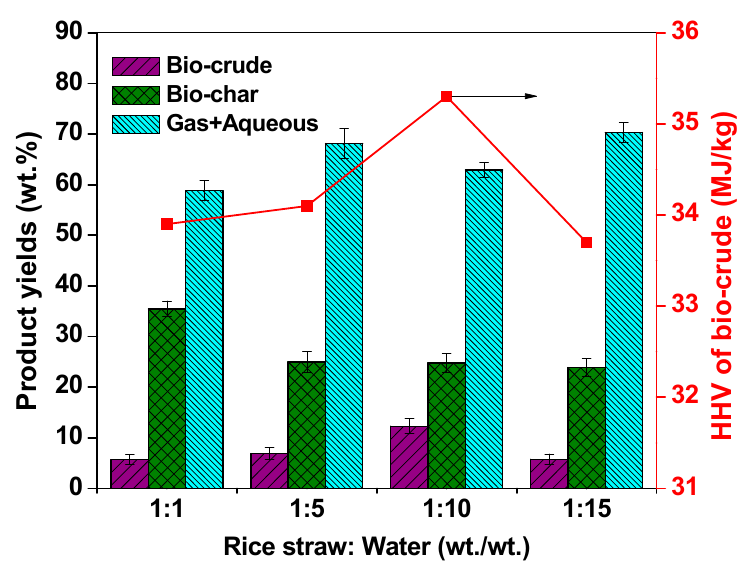
Figure 2. Effect of rice-straw-to-water ratio on product yields and HHV of bio-crude at a final temperature of 300 °C and 60 min.